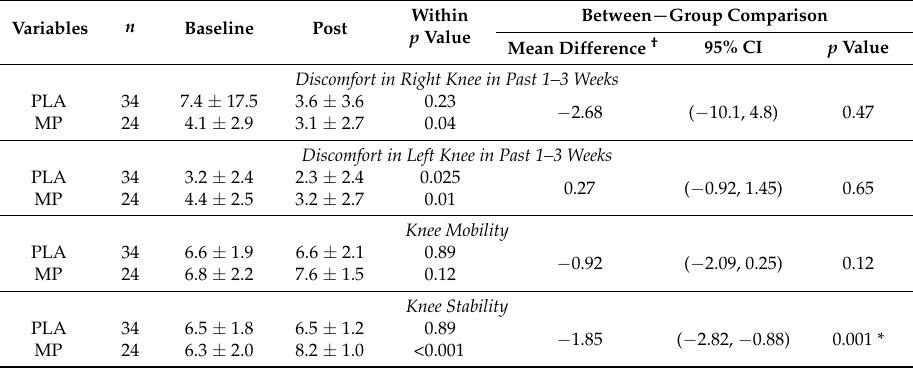
Table 4. Visual Analog Scales to Assess Pain and